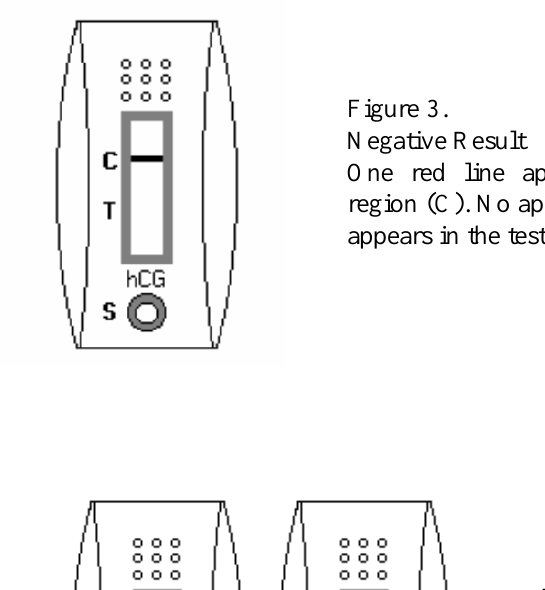
Figure 4. Invalid Result Control line fails to